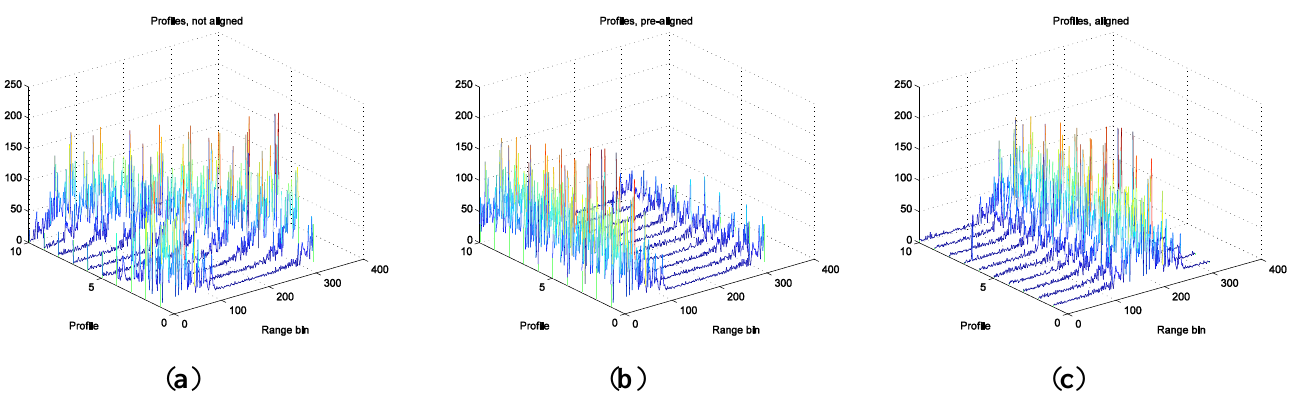
Figure 8. Profile alignment process; ( a ) initially misaligned HRRP; ( b ) pre-aligned HRRP; ( c ) aligned HRRP after translational motion